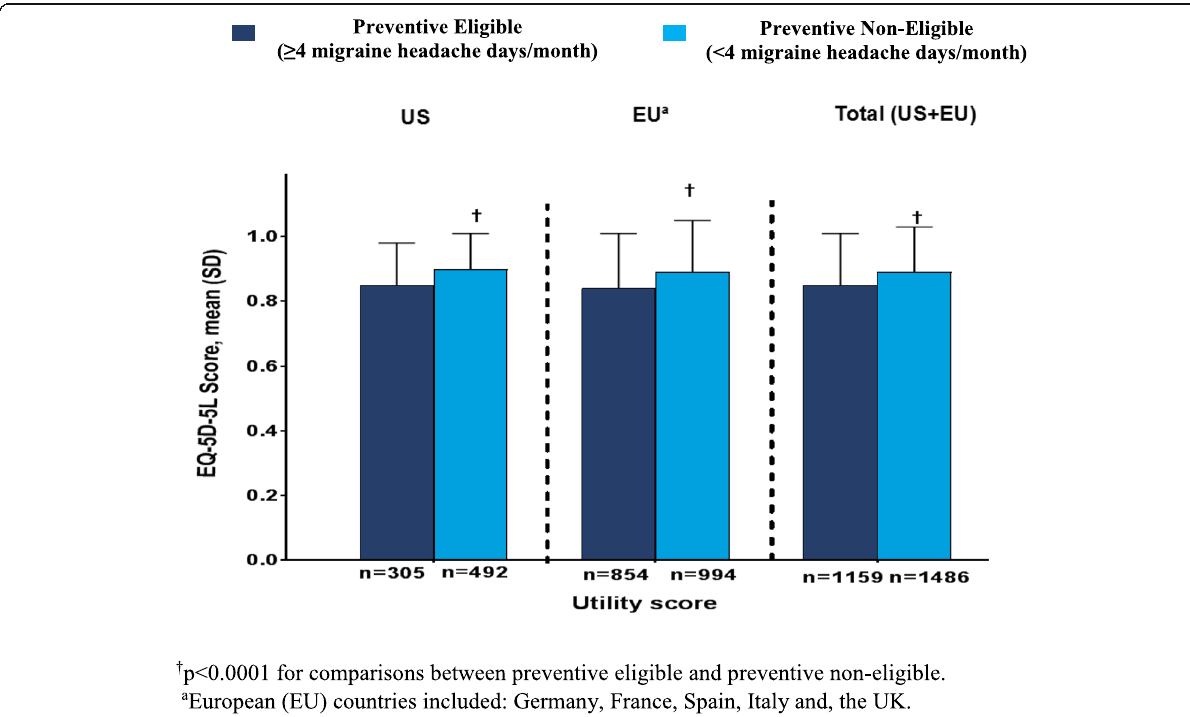
Fig. 4 EQ-5D-5L utility score in patients with migraine by preventive treatment eligibility